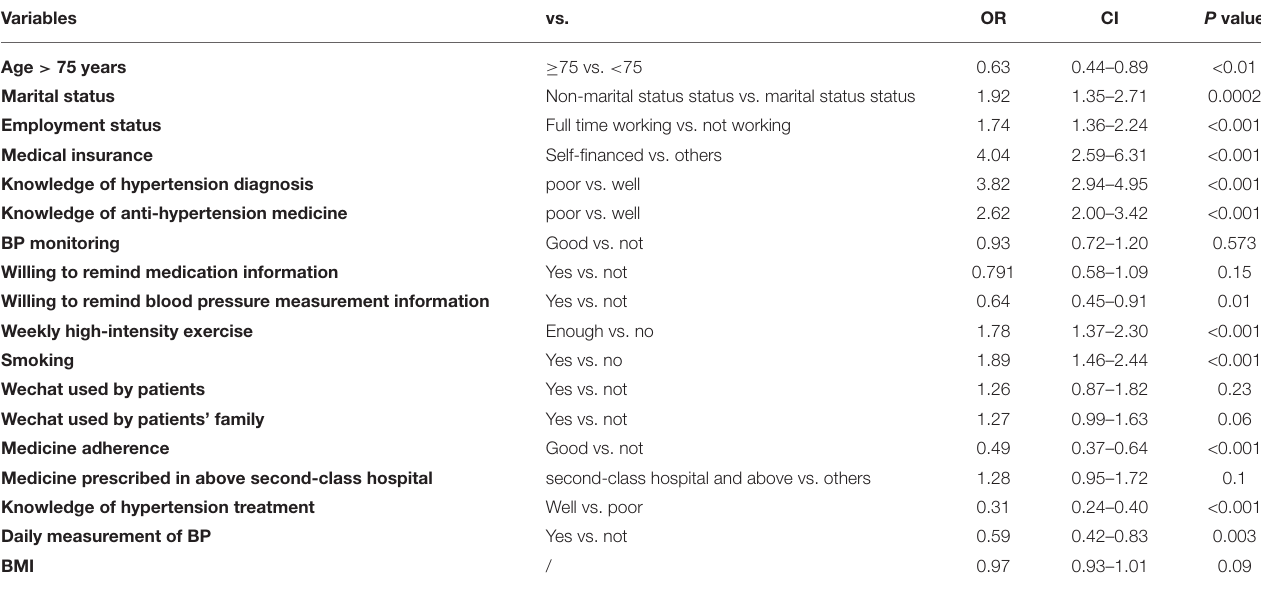
TABLE 2 | Logistics univariate analysis of substandard blood pressure control. Variables vs.